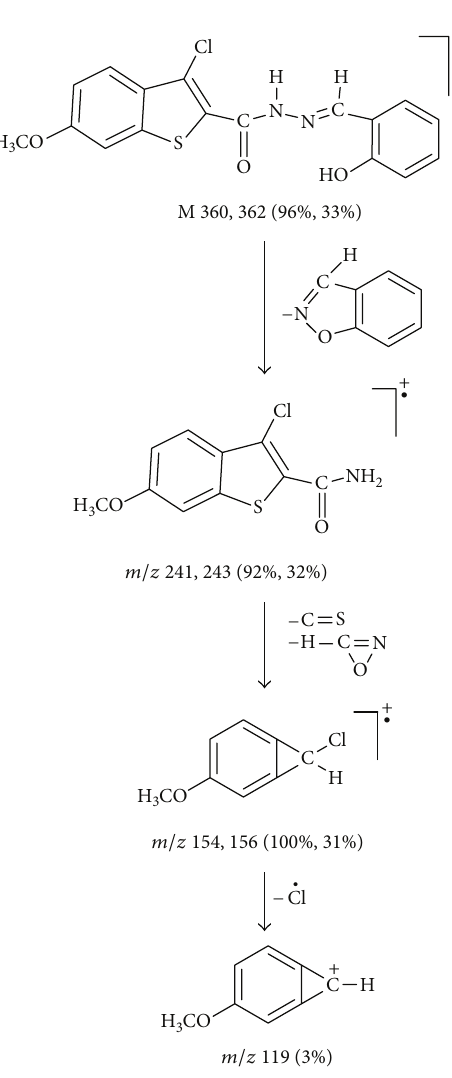
Scheme 2: Mass fragmention pattern of ligand